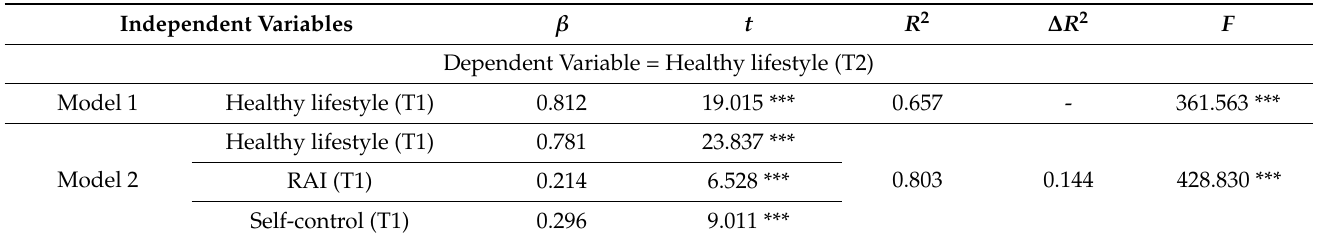
Table 3. Hierarchical regression analysis showing impact of autonomy and self-control on changes in healthy